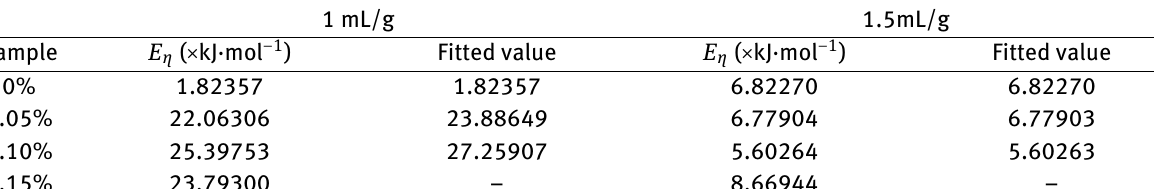
Table 11: Viscous flow activation energy and material constant of energetic materials contenting graphene at different solvent contenting.